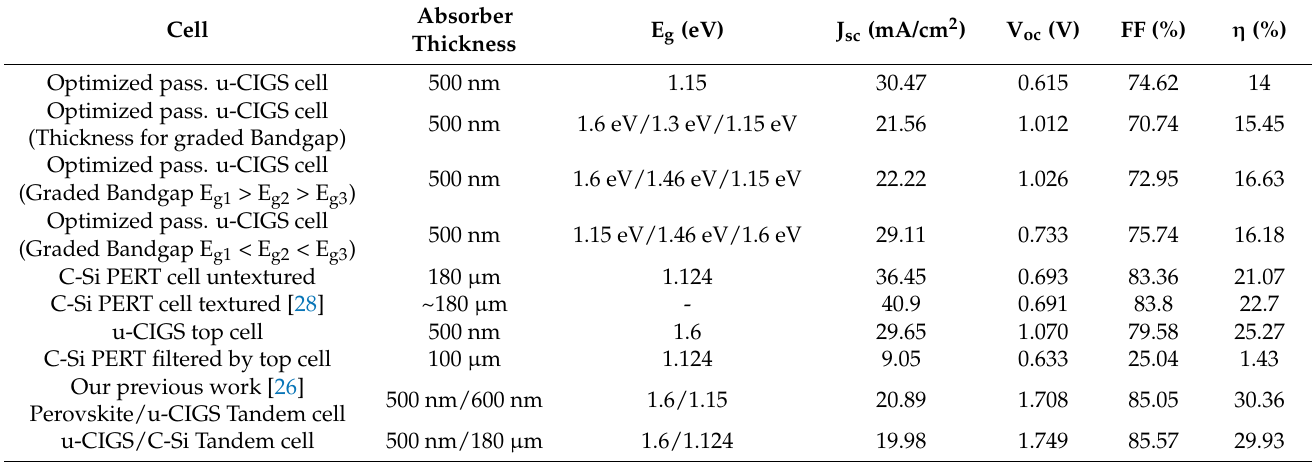
Figure 20. J–V curves of the optimized u-CIGS cells, C-Si PERT cell, and u-CIGS/C-Si PERT tandem solar cells at a fixed width grid of 25 µm. Table 4. PV characteristics of different ultrathin CIGS cells.